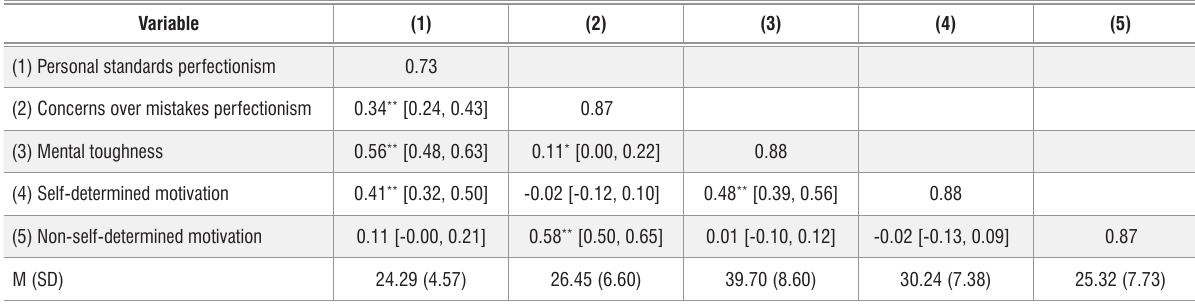
Descriptive statistics and bivariate associations among study variables